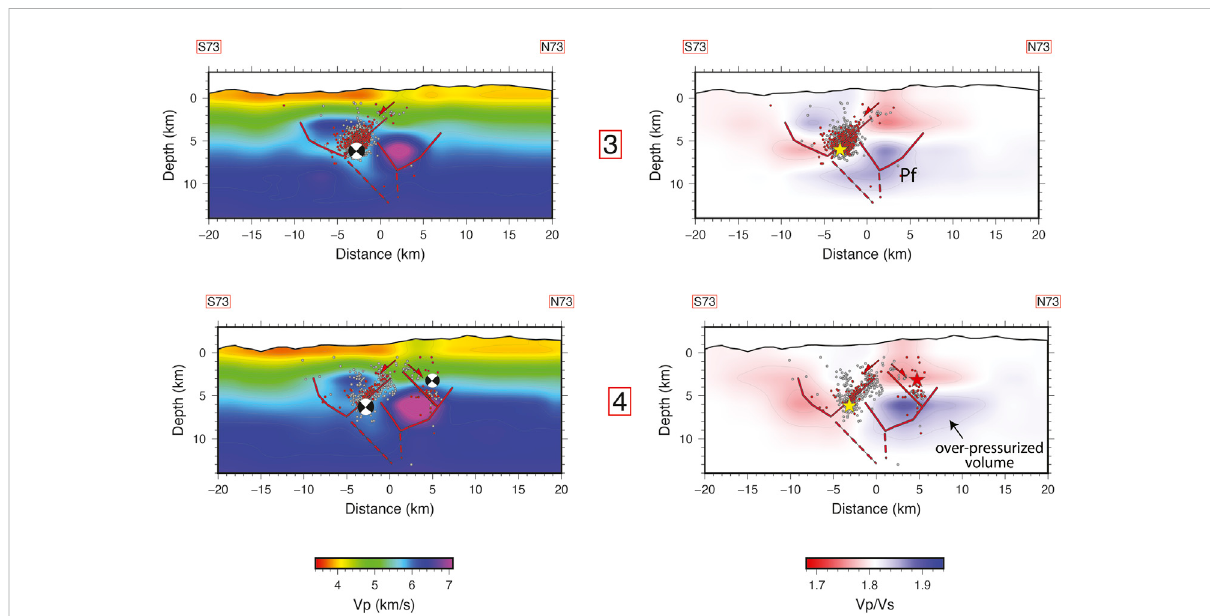
FIGURE 7 Selected vertical sections (Sections 3 and 4) of Vp and Vp/Vs with ageological sketch showing the segments of the pop-up structure (red lines) connected at depth with the Pollino fault (Pf). Hypocenter of he two major earthquakes are represented by their focal solution (http://cnt.rm.ingv.it/ tdmt.html;Scognamiglioetal., 2009)on theVptomograms, ontheleft,and byred- (28May2012, M L =4.3) and yellowstars (25October 2012, M L = 5), respectively, on the Vp/Vs tomograms, on the